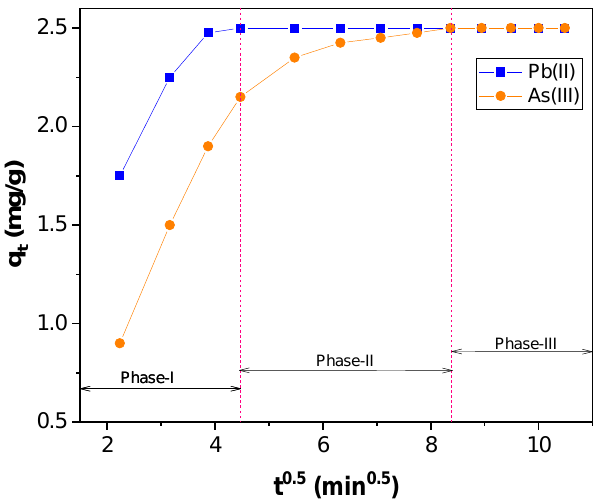
Figure 9. Weber-Morris intraparticle diffusion plot for Pb(II) and As(III) adsorption over CNTs – PAMAM – Ag. To further explore the adsorption equilibrium, the experimental results obtained for adsorption of Pb(II) and As(III) were analyzed with three isotherm models viz., the Lang- muir, the Freundlich, and the Temkin models. The Langmuir isotherm model assumes that monolayer adsorption occurs on the surface of the adsorbent [71]. Additionally, it presumes that the equivalent binding site number is specific and that adsorbate does not transmigrate [72]. Accordingly, the Langmuir model is represented by Equation (7). 𝐶 𝑒 = 𝐶 𝑒 + 𝑞 𝑒 𝑞 𝑚 where q e (mg/g) is the amount of adsorbed Pb(II) and As(III) per unit mass of CNTs – PA- MAM – Ag; C e (mg/L) is the concentration of Pb(II) and As(III) at equilibrium; q m is the maximum amount of the Pb(II) and As(III) adsorbed per unit mass of CNTs – PAMAM – Ag to form a complete monolayer on the surface-bound at high C e . K L is the Langmuir adsorption constant related to the free energy of adsorption. The linear fitting for the Langmuir plot of specific adsorption ( C e / q e ) versus the equilibrium concentration ( C e ) is shown in Figure 10a. The parameters calculated by the Langmuir isotherm model are tab- ulated in Table 2. The maximum adsorption capacity ( q m ) calculated for the adsorption of Pb(II) and As(III) was 18.7 and 14.8 mg/g, respectively.